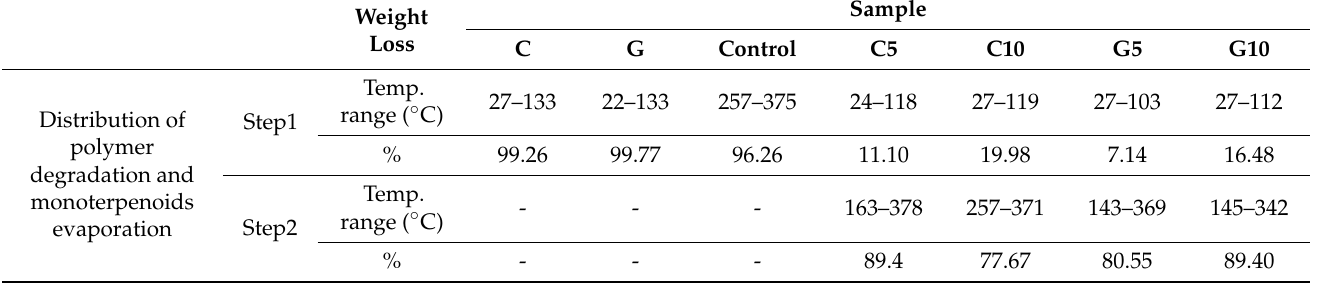
Table 2. Analysis (wt%) of electrospun PLA webs and monoterpenoids on thermogravimetric analysis (TGA).